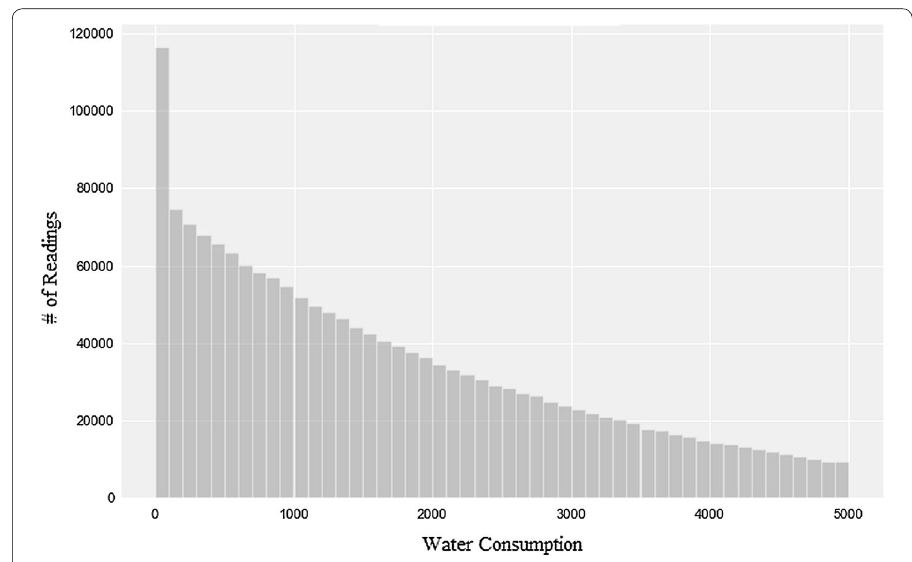
Fig. 7 X-Factor: water consumption values